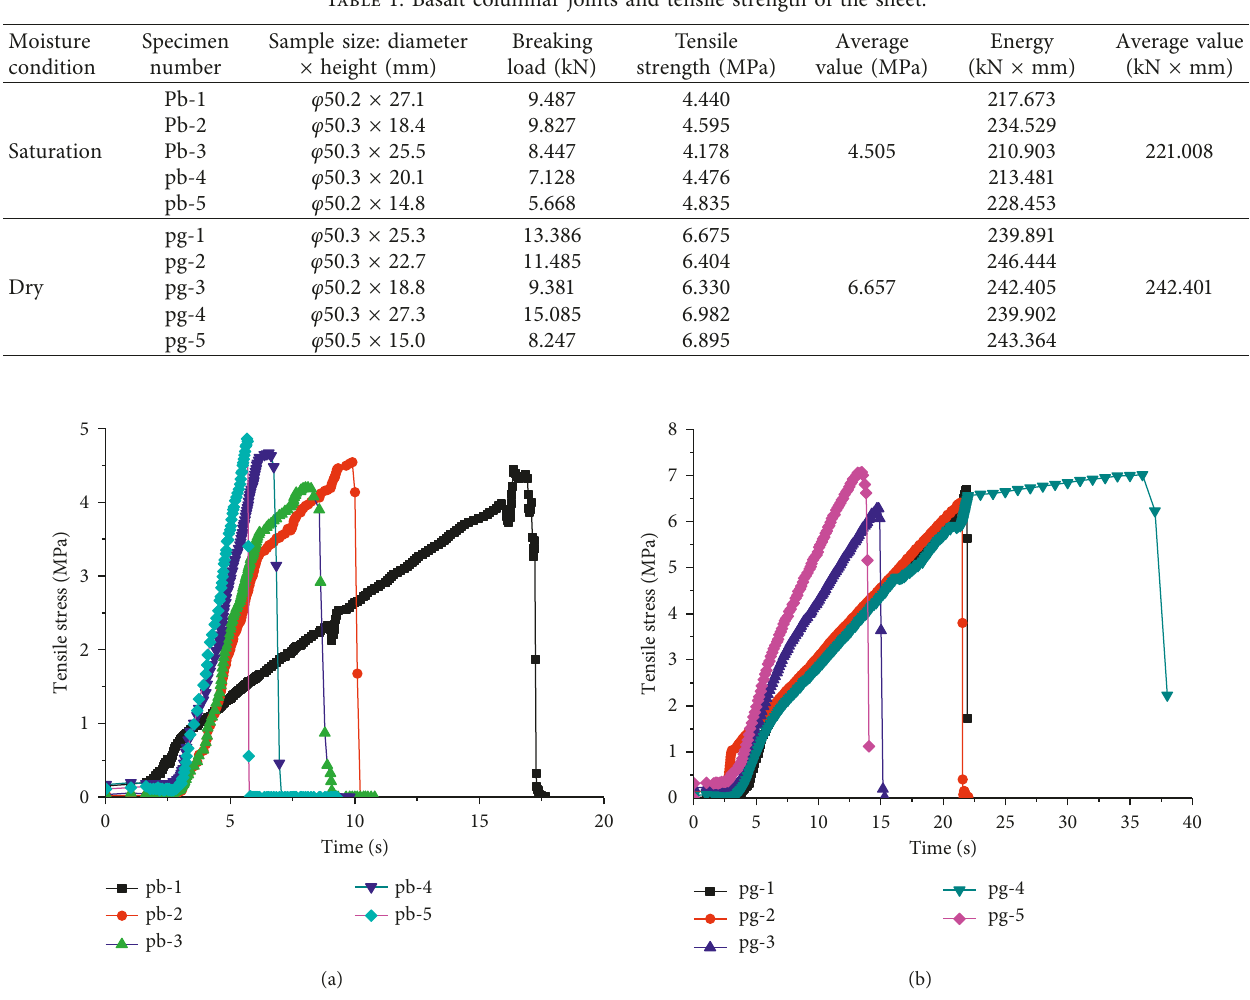
Figure 5: Splitting curve of the (a) saturated specimen and (b) dry